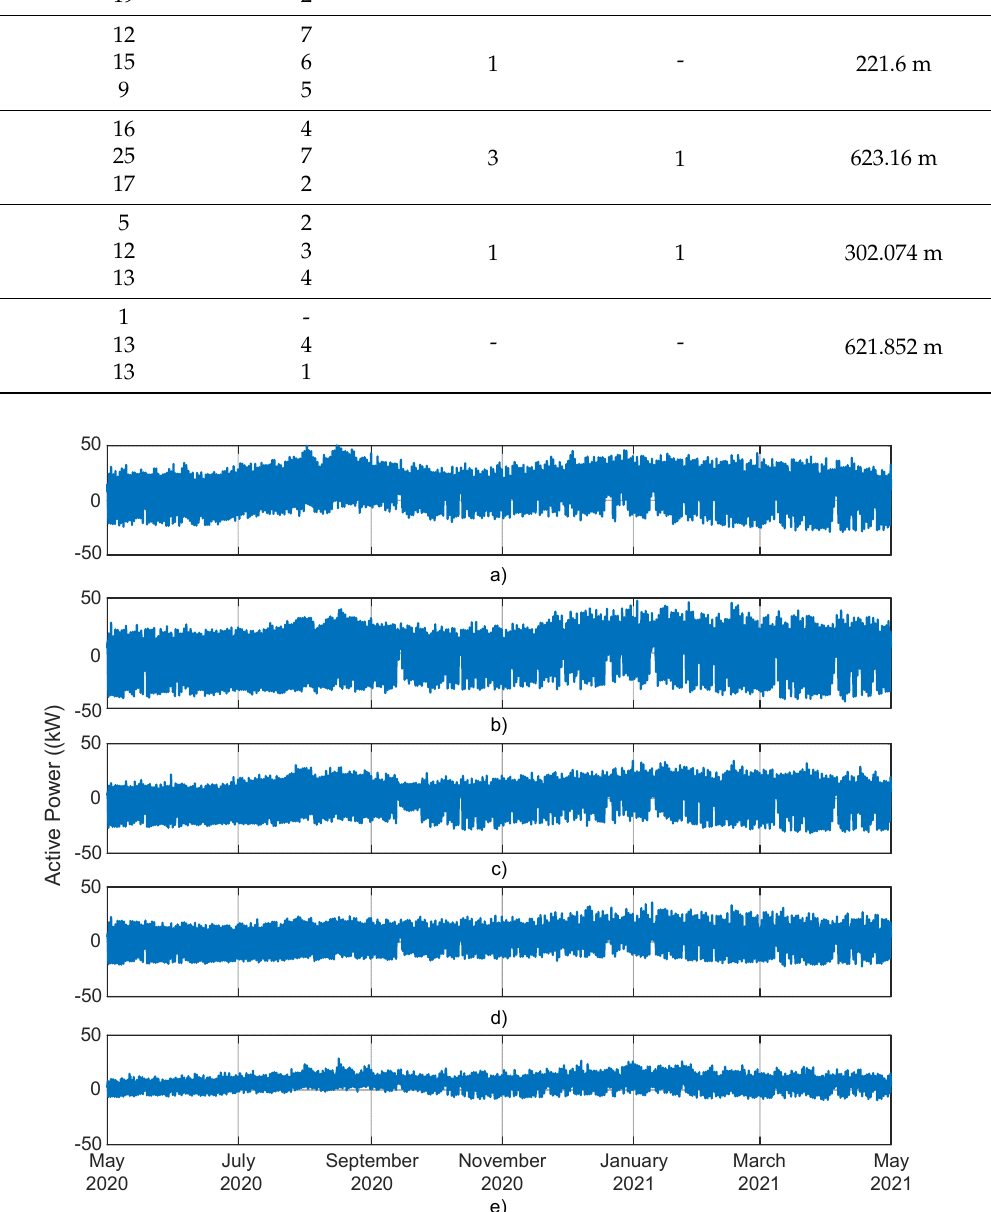
Figure 5. Daily Net-Demand Curve for each of the eCs during the considered period. ( a ) EC1 (Feeder 1). ( b ) EC2 (Feeder 2). ( c ) EC3 (Feeder 3). ( d ) EC4 (Feeder 4). ( e ) EC5 (Feeder 5). Positive active power values for the net-demand represent the power consumption by the consumer loads while negative active power values represent the reverse power flow due to the local PV generation. One of the primary concerns resulting from the reverse power flow is the significant voltage rise that can occur along the feeder. The feeder voltage could potentially increase enough to violate the ±10% steady state tolerance defined in the Enemalta network code [21]. The voltage levels of the other feeders in the LV network can also be affected by the reverse power flowing back to the substation transformer. An additional concern is that, on a larger scale, the reverse power flow could lead to dynamic stability issues. During instances of reverse power, there is a lack of system inertia, which is an issue when cou- pled with the intermittency risks associated with PV generation. One must note that this study was performed during the COVID-19 pandemic. The COVID-19 pandemic has affected every aspect of life, including the operation of the utility grid due to changes in the energy usage patterns of residential, commercial, and public entities. According to a study published by the Malta National Statistics Office [19], the total electricity supplied in 2020 amounted to 2496.4 GWh, which is a decrease of 5.4% when compared to the previous year. 4. Community BESSs for the RECs Community battery energy storage systems (BESSs) have a typical storage capacity ranging between tens of kilowatt-hours (kWh) and a few megawatt-hours (MWh). BESSs are an effective and energy efficient solution to limit reverse power flows in the LV distri- bution network. The community-scale BESSs can be sized according to a wide variety of site performance requirements. In this paper, the community-scale BESSs are deployed at specific nodes in the REC and controlled to reduce the power exchanges with the medium